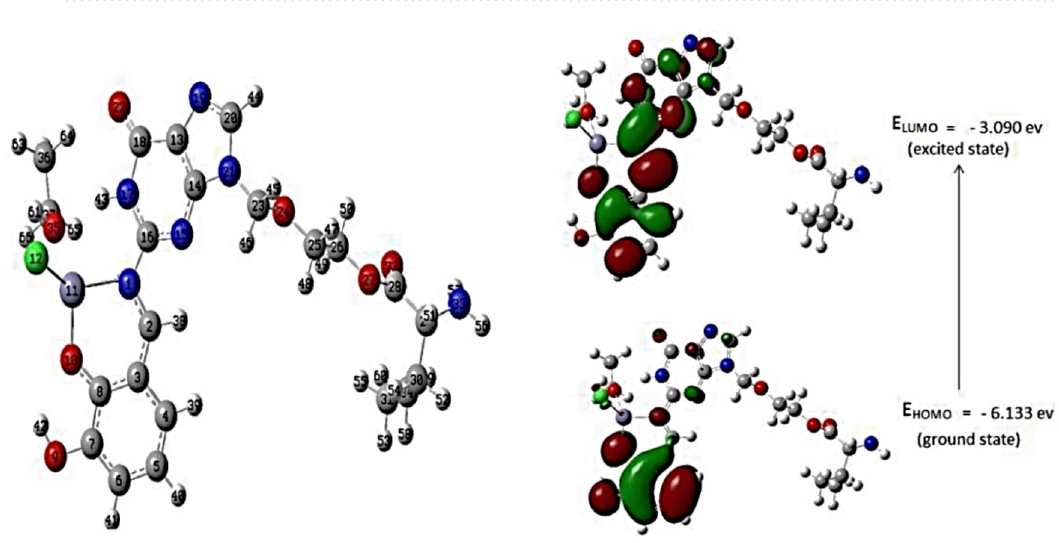
Figure 10. The optimized geometry and HOMO–LUMO energies for the Zn(II) complex